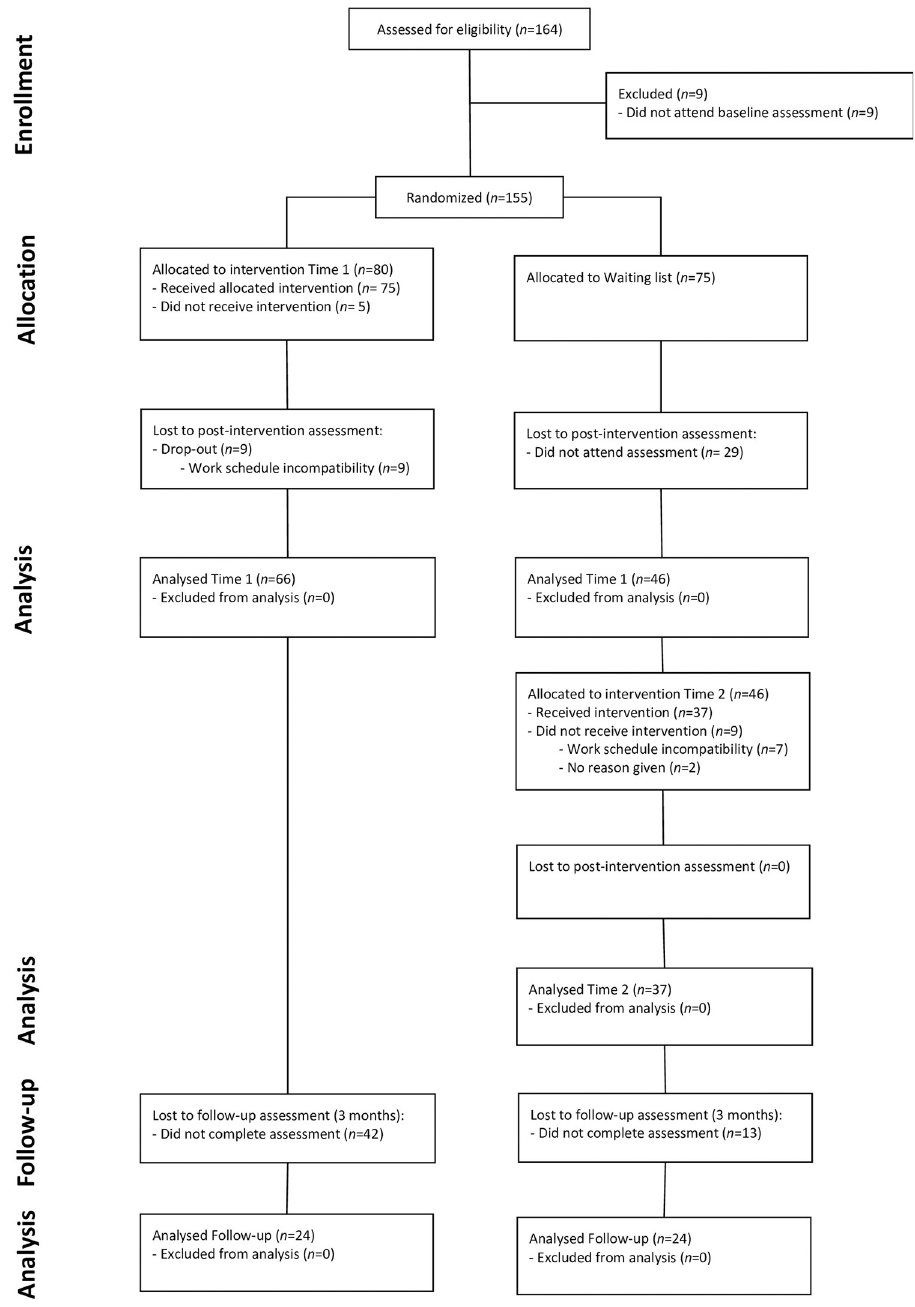
Fig 1. Flowchart of study